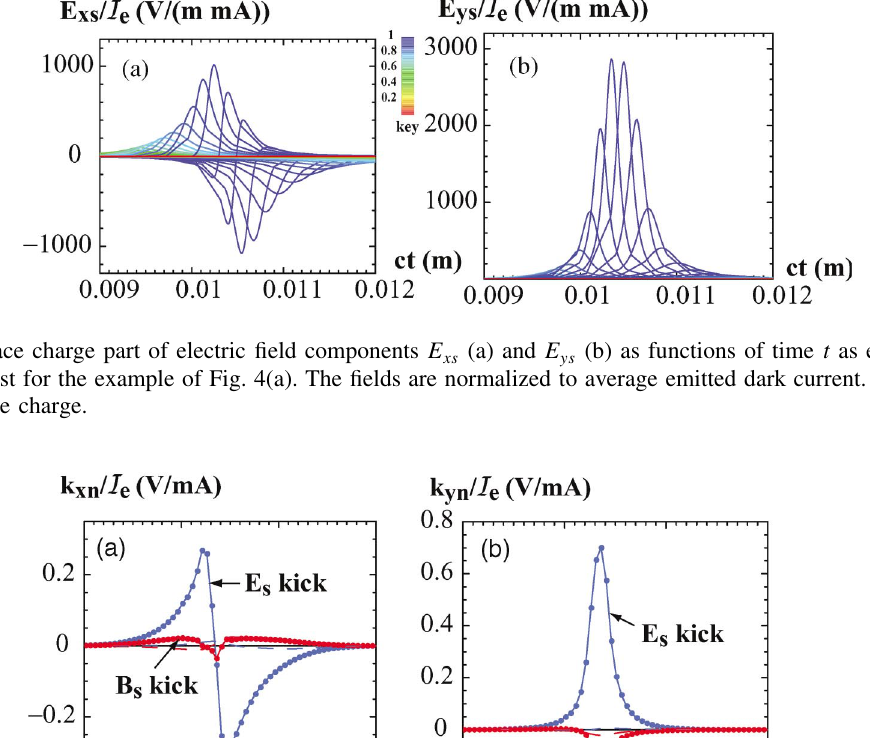
FIG. 13. (Color) Contribution of the individual (dark current) macroparticles to kicks in x (a) and y (b), experienced by a test particle (on crest) for the example of Fig. 4(a). The macroparticles are indexed by rf phase at emission, (cid:22) (their spacing is 1 (cid:7) ). The E ( B ) field contribution is shown in blue (red); the space charge (acceleration) fields contribution is indicated by solid (dashed)